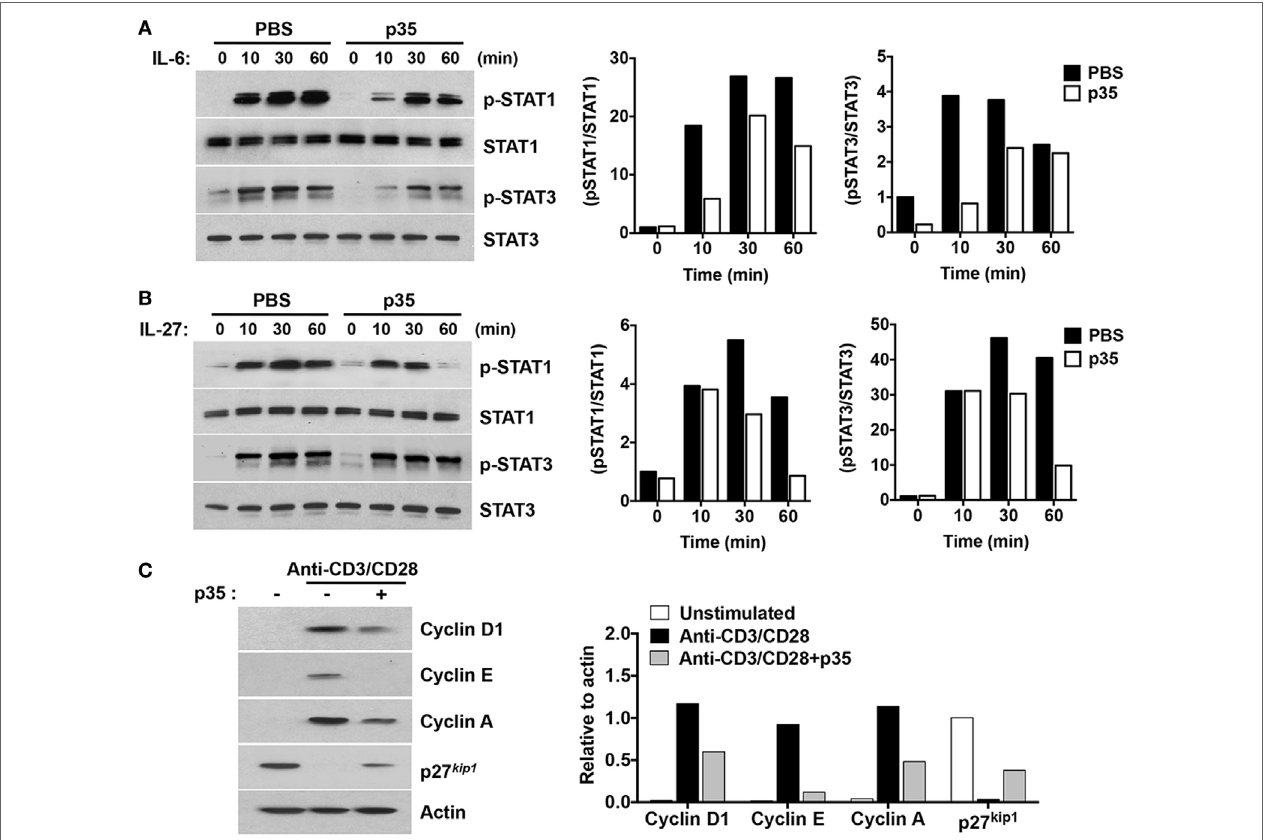
FigUre 4 | IL-12p35 inhibits STAT signaling pathway and cell-cycle regulatory proteins. (a,B) CD4 + T cells were stimulated in anti-CD3 coated plates and with anti-CD28 for 72 h. The cells were then washed, cultured in serum-free medium with p35 for 2 h, followed by stimulation with IL-6 or IL-27 for the indicated time periods. (c) Purified CD4 + T cells were TCR activated for 48 h as described earlier. Whole cell lysates were analyzed by Western blotting. Protein levels were normalized to total STAT or β -actin and quantified using Image-J software. Data are representative of at least three